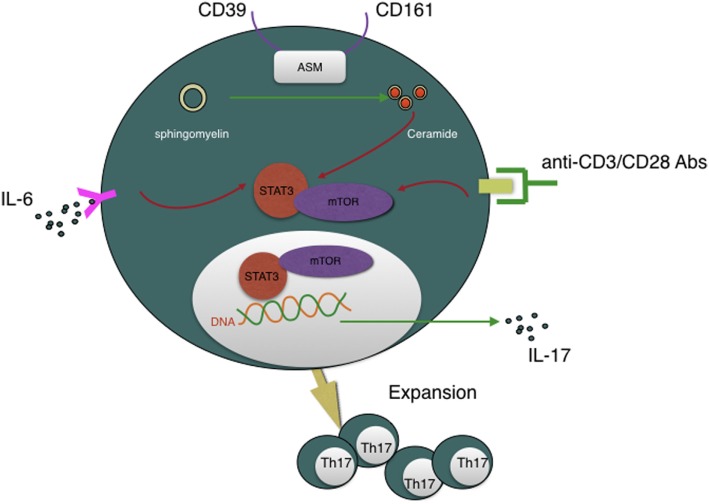
CD39 is involved in Th17 cells expansion and IL-17 secretion and, moreover, CD4+CD39+CD161+ T cells can be regarded as Th17 cells precursors. CD39, combined with CD161, can initiate acid sphingomyelinase enzymatic activity, subsequently, increase intracellular ceramide concentration, then impact STAT3 and mTOR signal transduction, which are essential for Th17 generation and IL-17 secretion.